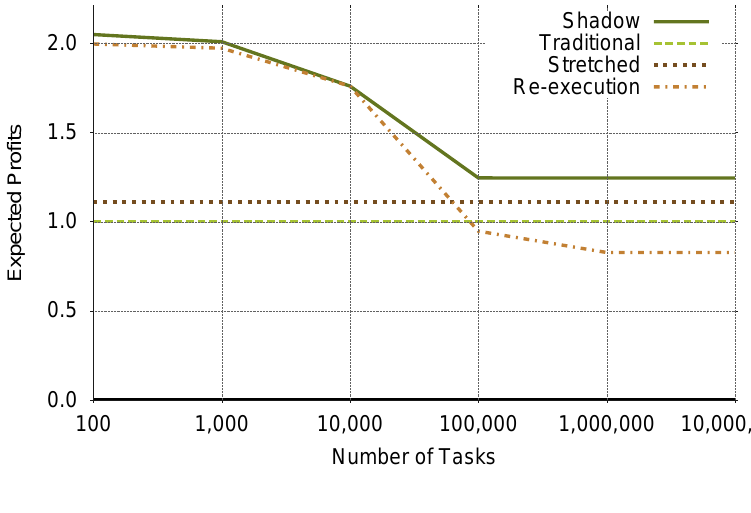
Figure 5. Profit for different number of tasks. ρ = 0.5, MTBF = 5 years, W = 1 h, t t = 2.6 h. R 2